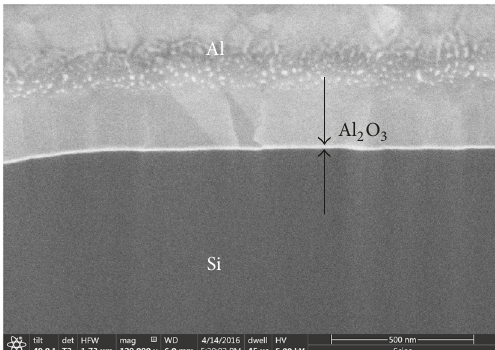
Figure 9: Scanning electron microscopy image for Al/Al 2 O 3 /Si structure (Al 2 O 3 = 20 nm, annealing in N 2 at 300 ∘ C) after FIB preparation of a traverse-cut face (using secondary electrons of an intralens detector for morphology imaging). A smooth transition between all materials is observed, while the polycrystalline nature of the metal electrode is also